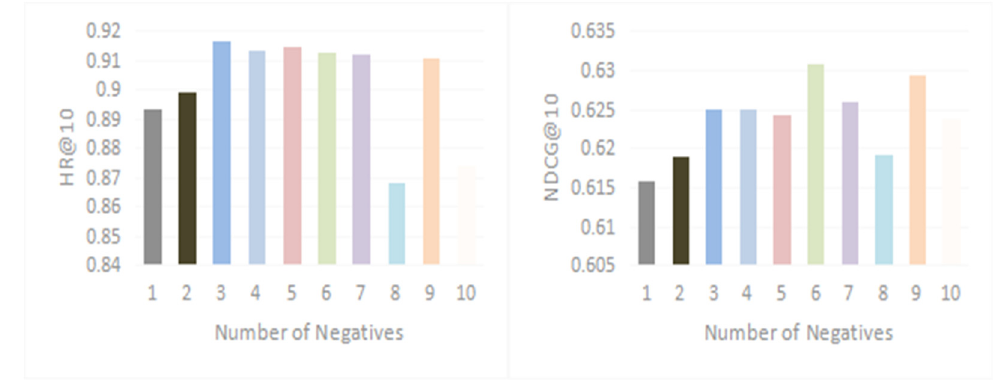
Figure 3. The effect of ρ on Lastfm.